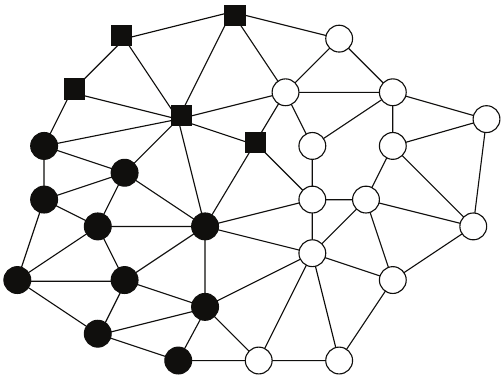
F 1: Examples of aggregates for a 2D domain. e nodes marked with “